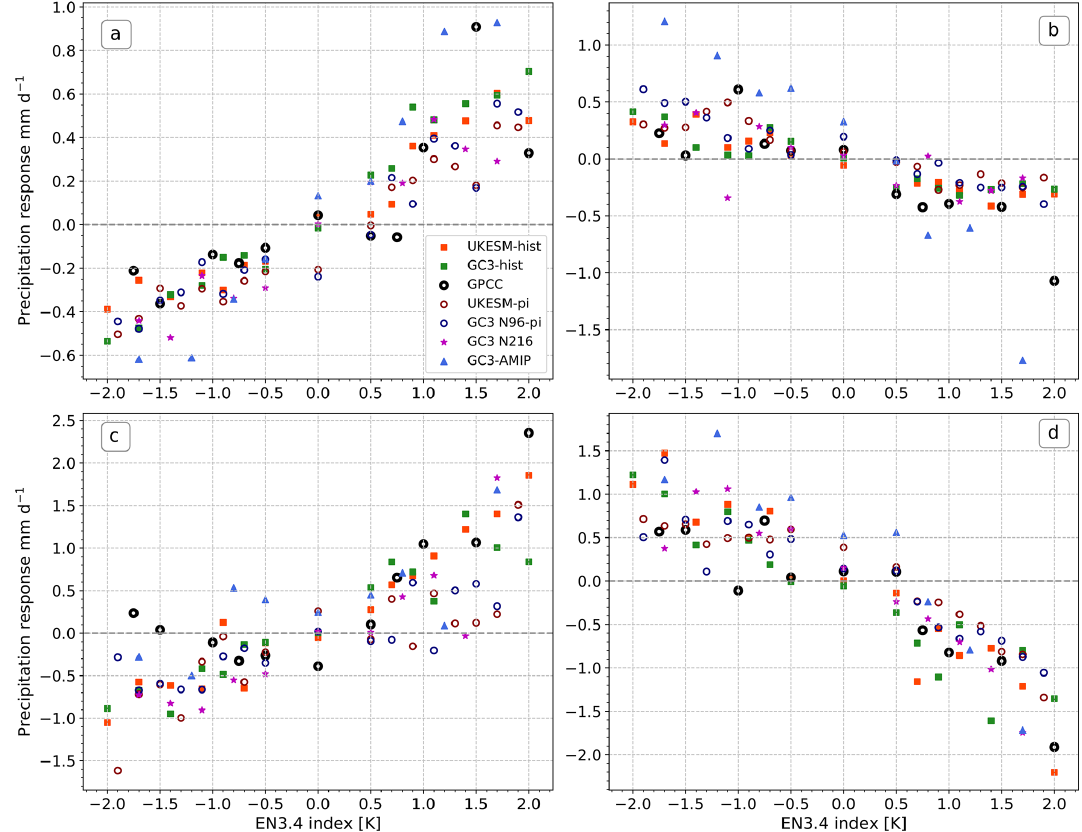
Figure 12. Precipitation response (mmd − 1 ) as a function of the El Niño 3.4 index (see Sect. 5) for (a) southwestern North America (20– 37 ◦ N, 112–98 ◦ W), (b) Central America and southern Mexico (5–19 ◦ N, 95–83 ◦ W), (c) southeastern South America (35–25 ◦ S, 60–50 ◦ W), and (d) the Amazon (10–0 ◦ S, 70–45 ◦ W). The observation scatter points are from GPCC in the period of